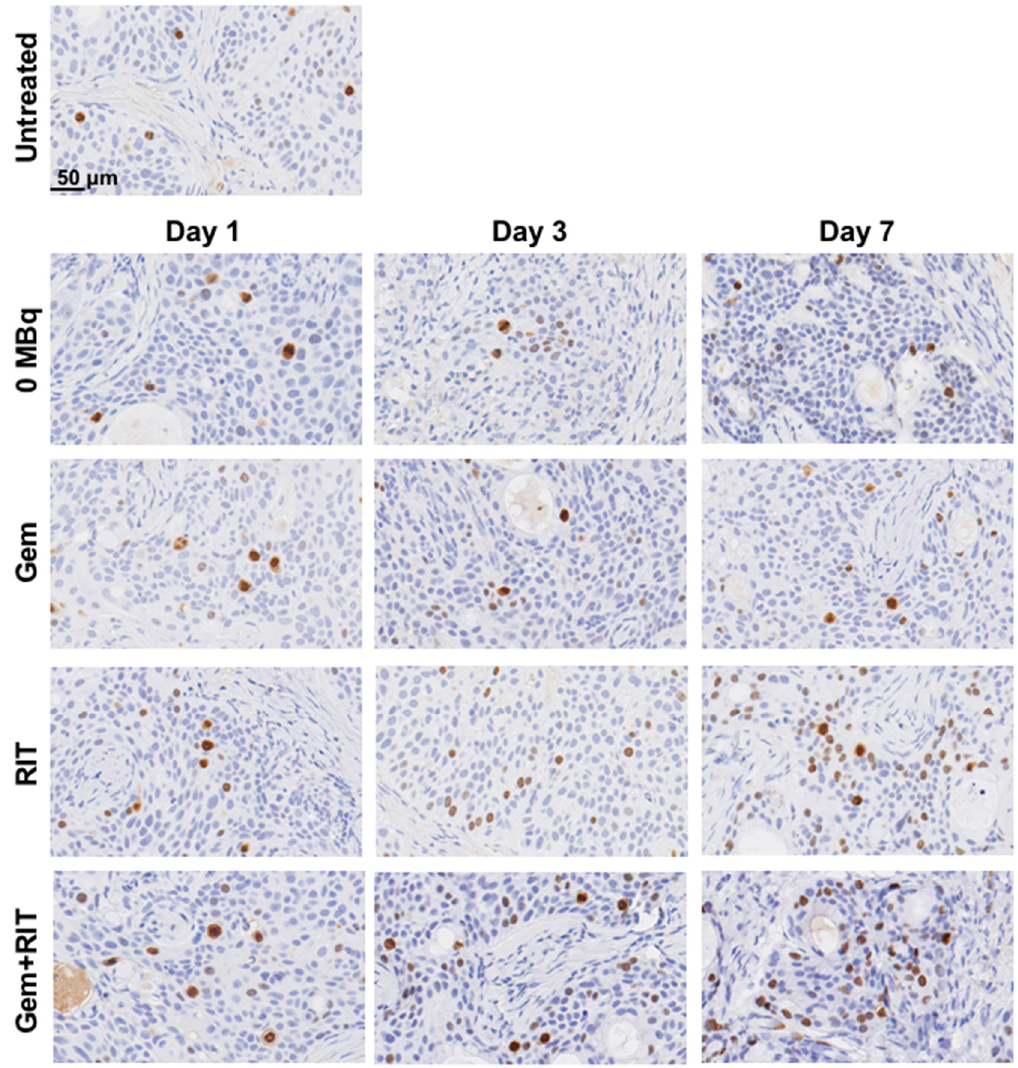
Figure 8. Ki-67-stained BxPC-3-tumor sections at days 1, 3, and 7 after i.v. injection of intact anti-CD147 antibody 059-053 (0 MBq), gemcitabine (gem, 240 mg/kg body weight) alone, 3.7 MBq of 90 Y-labeled 059-053 (RIT) alone, and the combination of gem plus RIT (one-cycle regimen). The Ki-67 antigen was detected using an anti-human Ki-67 polyclonal antibody as the primary antibody (diluted 1:100). 2.7. Tumor Growth Curve Following External Beam Radiation with X-rays with or without